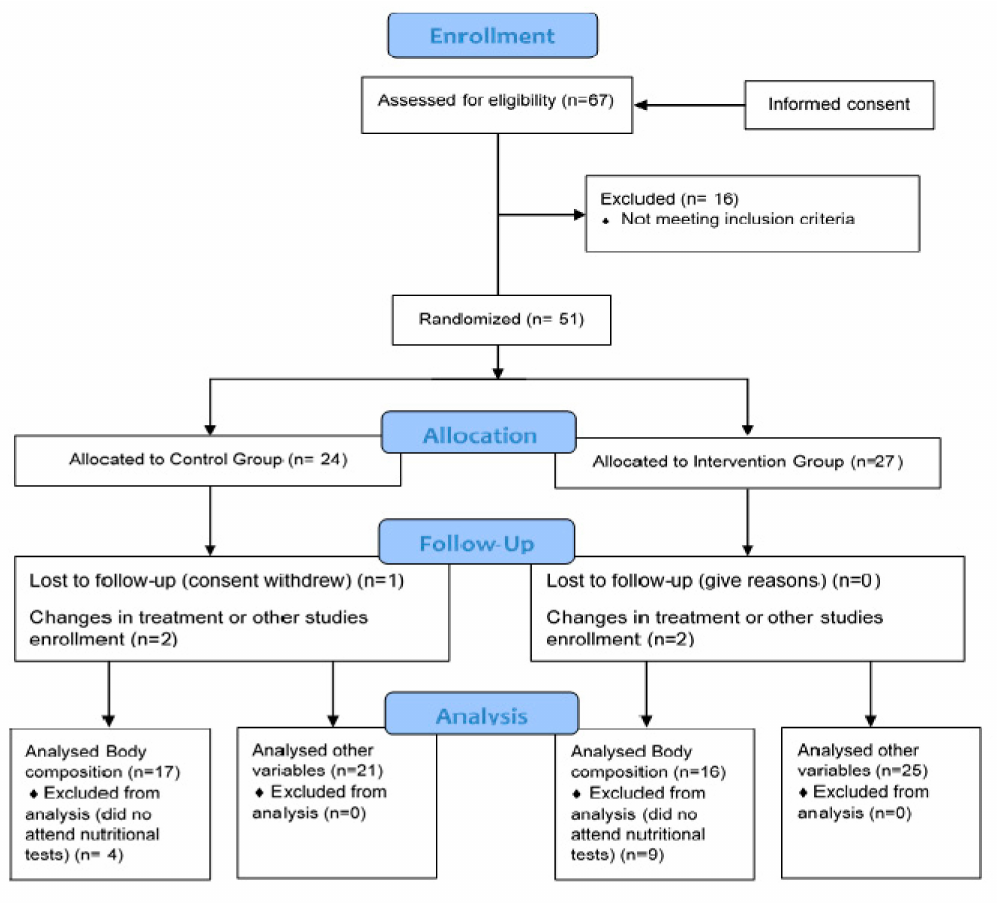
Figure 1. Consort flow